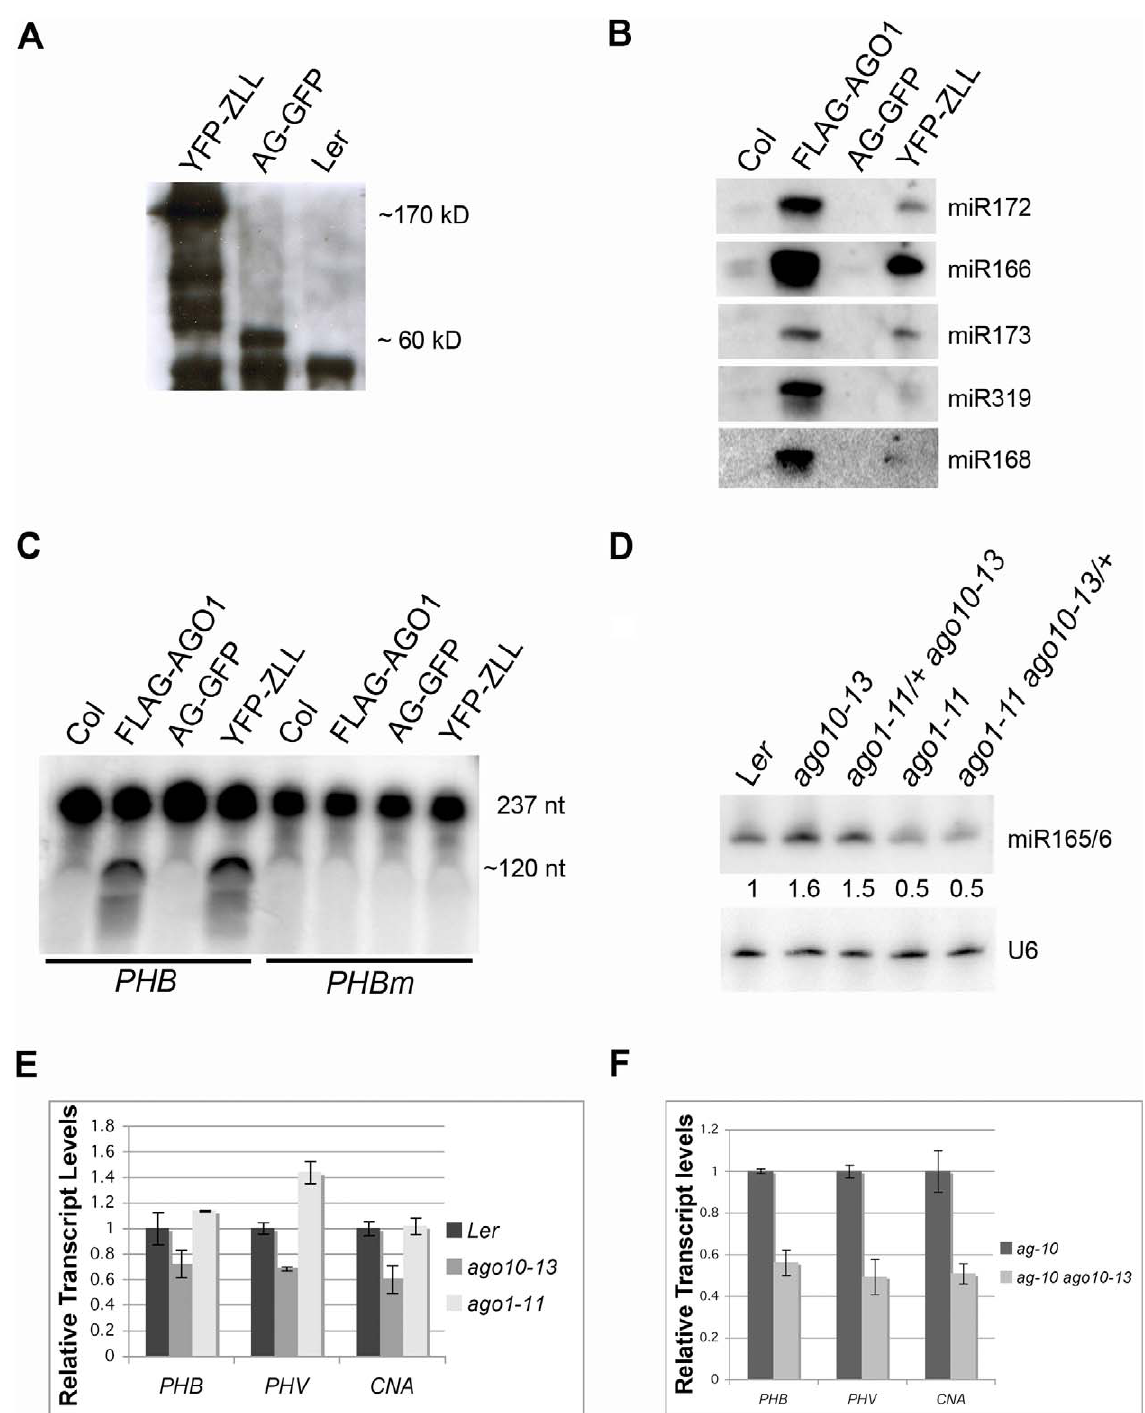
Figure 5. AGO10 is associated with miRNAs invivo and is catalytically active as a ‘‘slicer’’ invitro . (A) Immunoprecipitation (IP) followed by western blotting using anti-GFP antibodies from three genotypes as indicated. The immunoprecipitated YFP-ZLL fusion protein could be detected as a band of the expected size ( , 170 kD). AG-GFP ( , 60 kD) and L er served as a positive and a negative control for the IP, respectively. (B) Detection of miRNAs by northern blotting from FLAG-AGO1 and YFP-ZLL IP. Col and AG-GFP served as negative controls for FLAG-AGO1 and YFP-ZLL, respectively. (C) An in vitro ‘‘slicer’’ assay. Both FLAG-AGO1 and YFP-ZLL immune complexes cleaved the PHB wild-type probe, but not the miR165/ 166-resistant probe. The full-length PHB and PHBm probes were 237 nt. The 5 9 and 3 9 cleavage fragments were 112 nt and 125 nt, respectively, and were not separated in the gel (represented by the band of approximately 120 nt). (D) Northern blot for miR165/166 in the genotypes as indicated. U6 served as a loading control. The numbers below the gel image indicate the relative abundance of miR165/166. (E) Expression of the HD-Zip genes PHB , PHV and CNA in wild type (L er ), ago10-13 , and ago1-11 inflorescences as examined by realtime RT-PCR. (F) Realtime RT-PCR to determine the levels of PHB , PHV , and CNA mRNAs in ag-10 and ag-10 ago10-13 inflorescences.